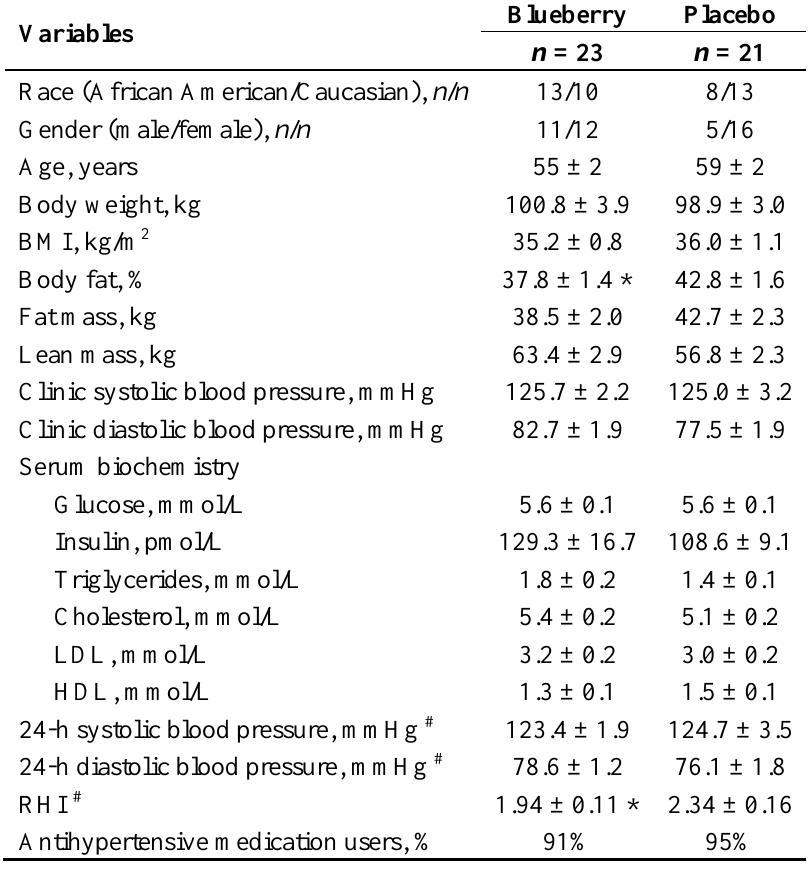
Table 2. Baseline characteristics of participants with metabolic syndrome.